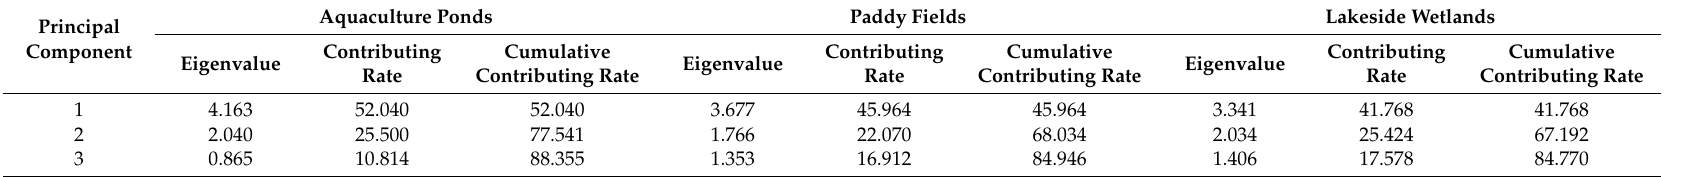
Table 5. Total variance explained of principal components in di ff erent habitats.